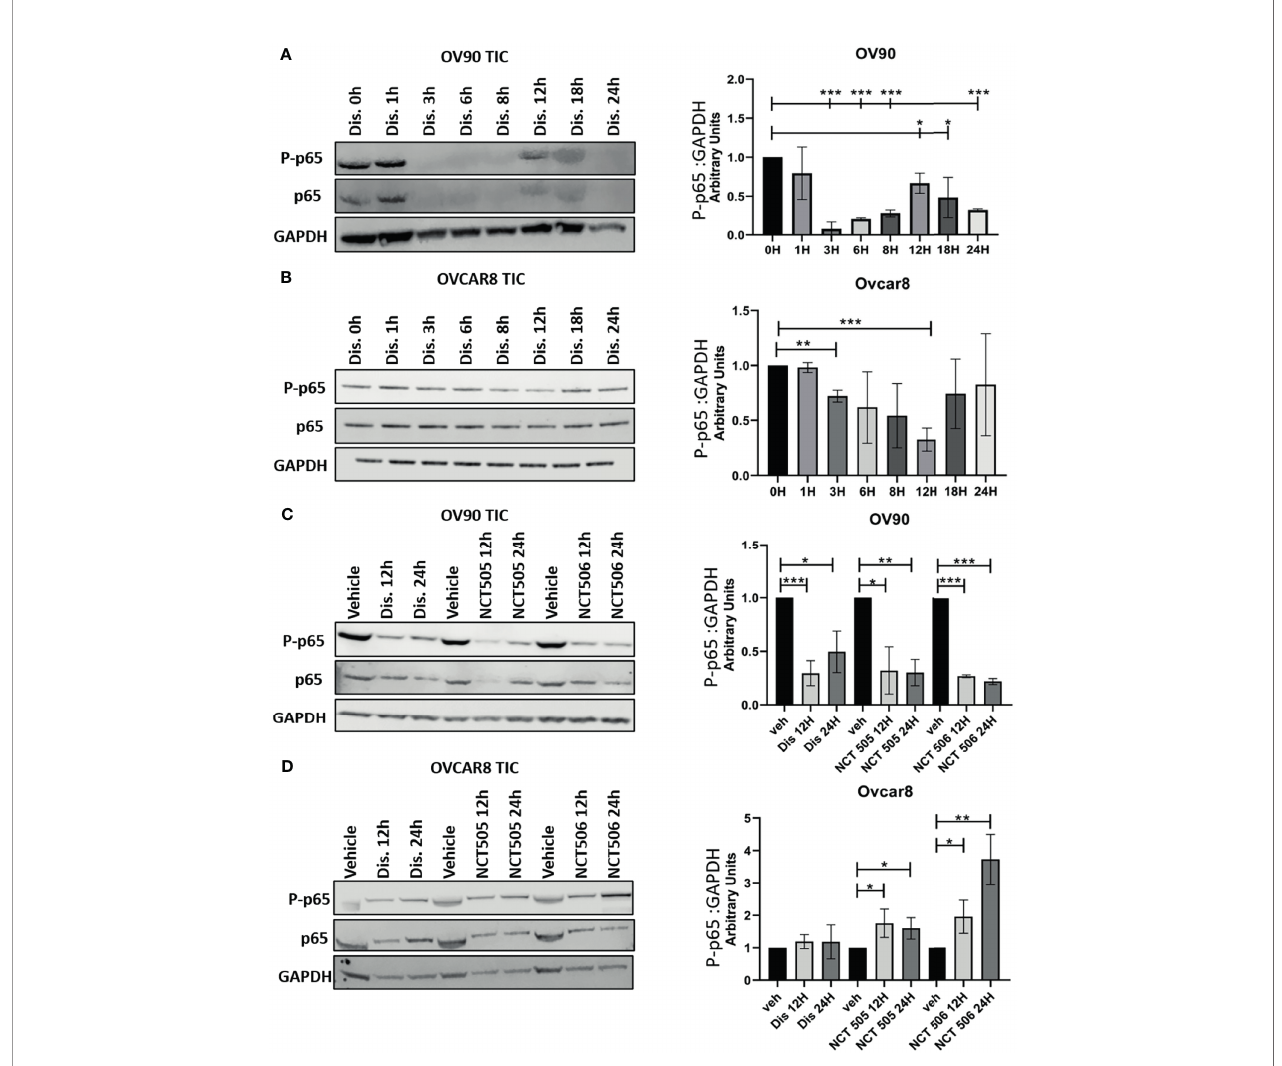
FIGURE 6 | Detection of classical NF k B activation in OV90 and OVCAR8 TICs by Western blot analysis. Following treatment with disul fi ram, lysates of (A) OV90 and (B) OVCAR8 TICs were probed for the expression of phosphorylated p65 at the indicated time points. (C) OV90 and (D) OVCAR8 TICs were probed for the expression of phosphorylated p65 12 and 24 h after treatment with disul fi ram, NCT-505, and NCT-506. Results were quanti fi ed comparing ratios of densitometry measurements of phosphorylated p65 to the normalized loading control. The resulting ratios are summarized by the graphs for each indicated cell line and treatment. Graphs represent mean and SEM of each treatment, from 3 independent experiments, *p < 0.05, **p < 0.01, ***p < 0.001, compared to vehicle